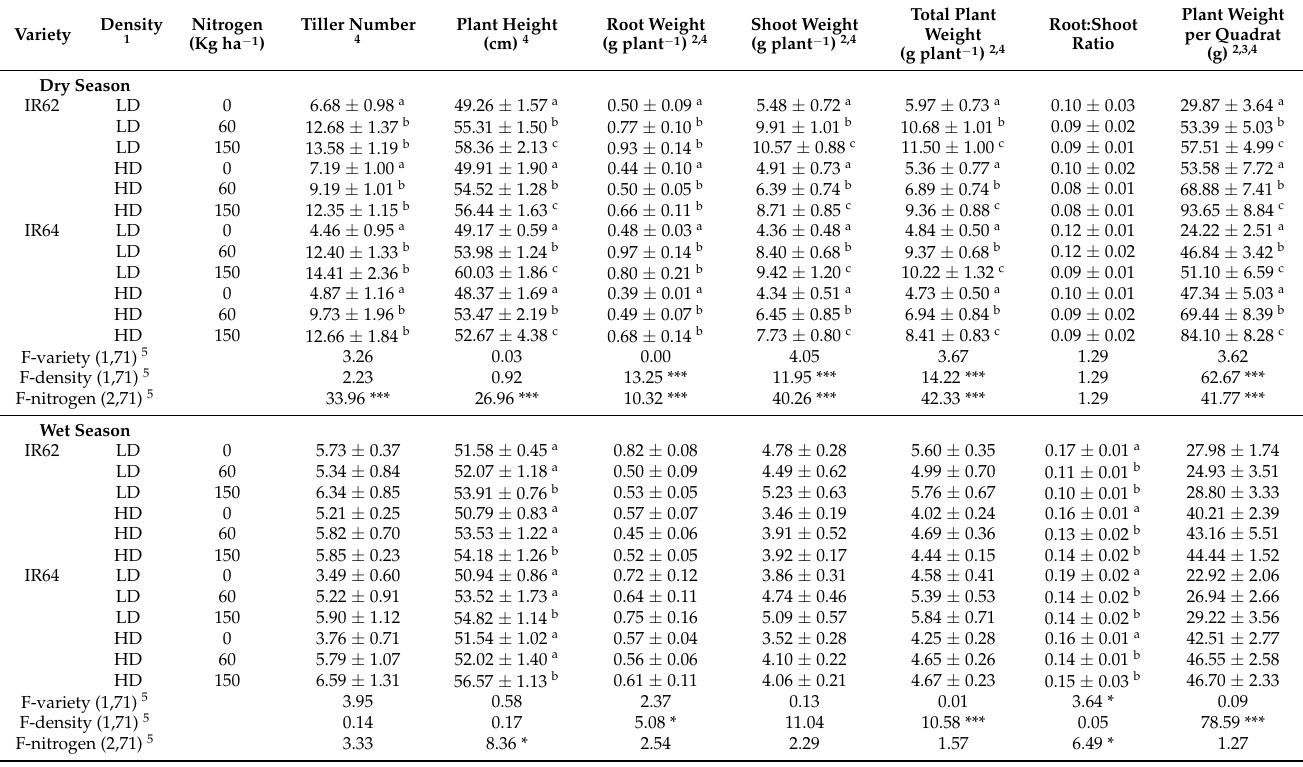
Table 1. Rice plant condition at 30 DAT during the 2013 dry and wet seasons. Numbers are means ±